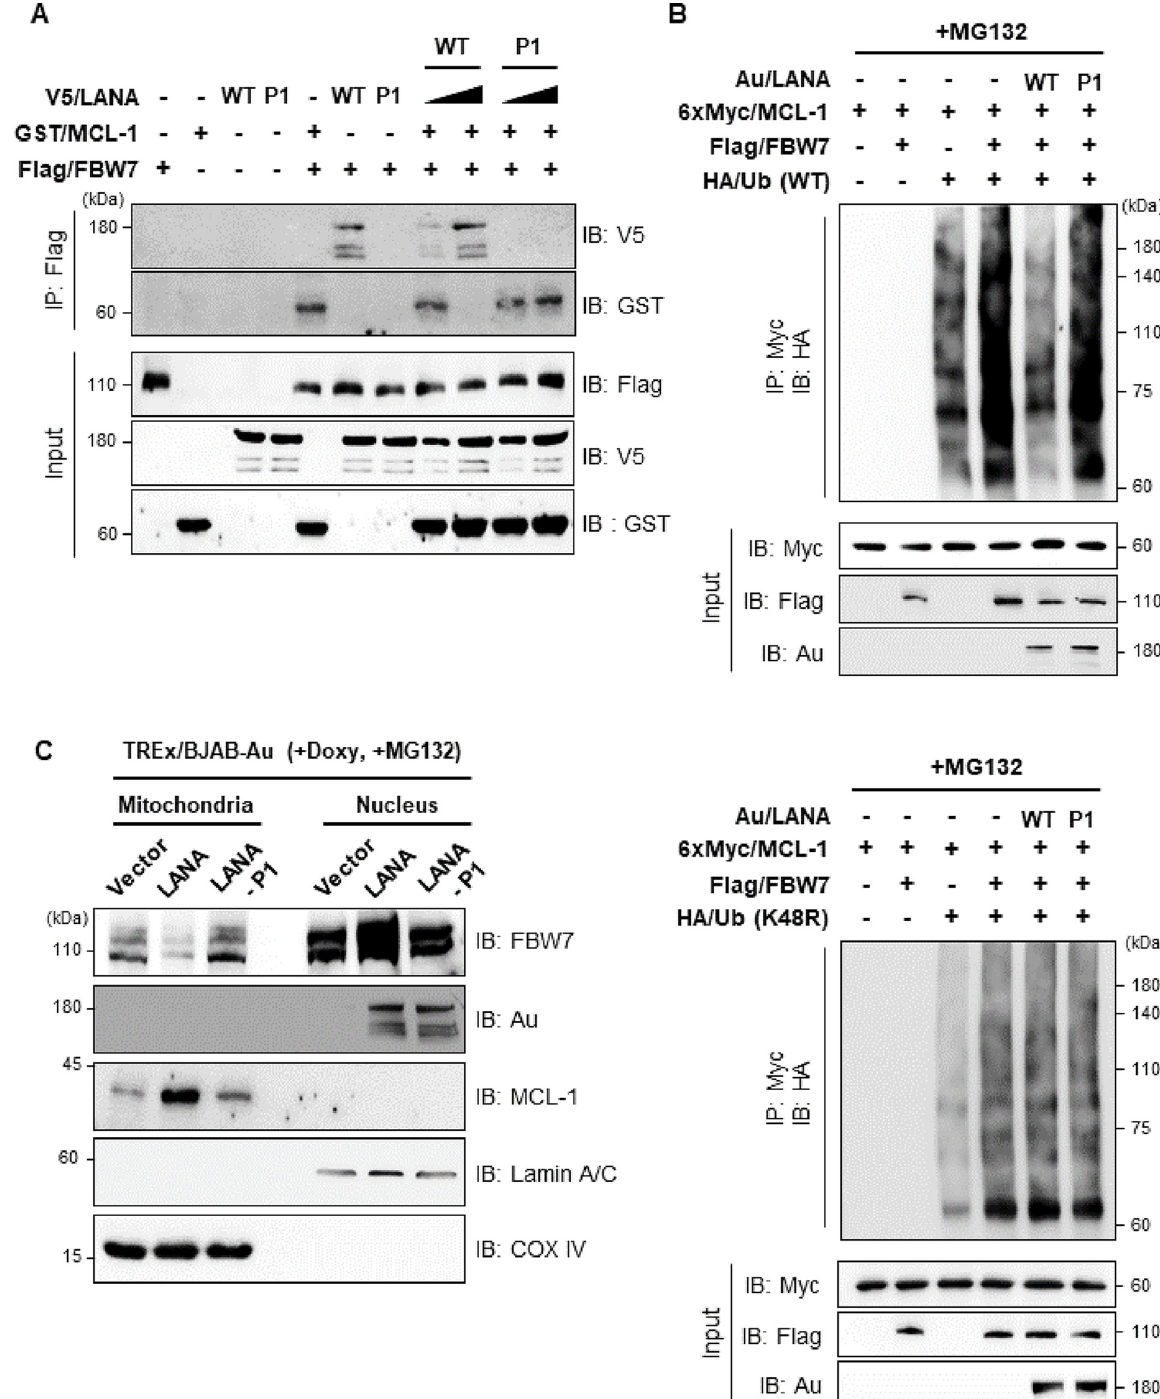
Fig 3. The KSHV LANA-FBW7 interaction dramatically reduces ubiquitination of MCL-1. (A) 293T cells were transfected with different combinations of plasmids. The cells were then treated with CHX (20 μ g/ml) for the indicated periods, followed by IP with an anti-Flag antibody and IB with either an anti-V5 or an anti-GST antibody. (B) 293T cells were co-transfected with the indicated LANA constructs along with the FBW7, MCL-1, and ubiquitin constructs. The cells were then treated with MG132 (10 μ M), followed by IP with an anti-Myc antibody and IB with an anti-HA antibody. (C) TREx/BJAB cells stably expressing vector, LANA-WT or LANA-P1 were treated with Doxy (1 μ g/ml) together with MG132 (10 μ M), followed by subcellular fractionation and IB with indicated antibody. Nuclear membrane protein Lamin A/C and mitochondrial protein COX-IV were shown as an indicator of nuclear or mitochondrial fraction,